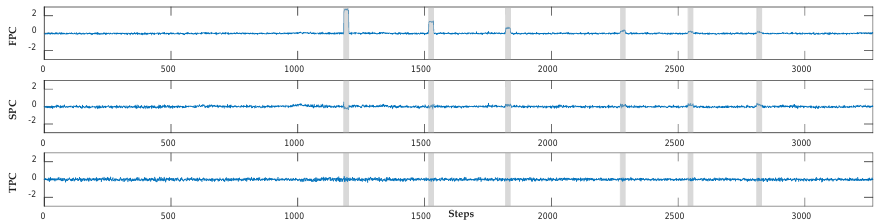
Figure 11. The first to third principal components of the corrected spectrum of phenol samples. FPC represents the first principal component of the UV-Vis spectrum; SPC represents the second principal component of the UV-Vis spectrum; TPC represents the third principal component of the UV-Vis spectrum.